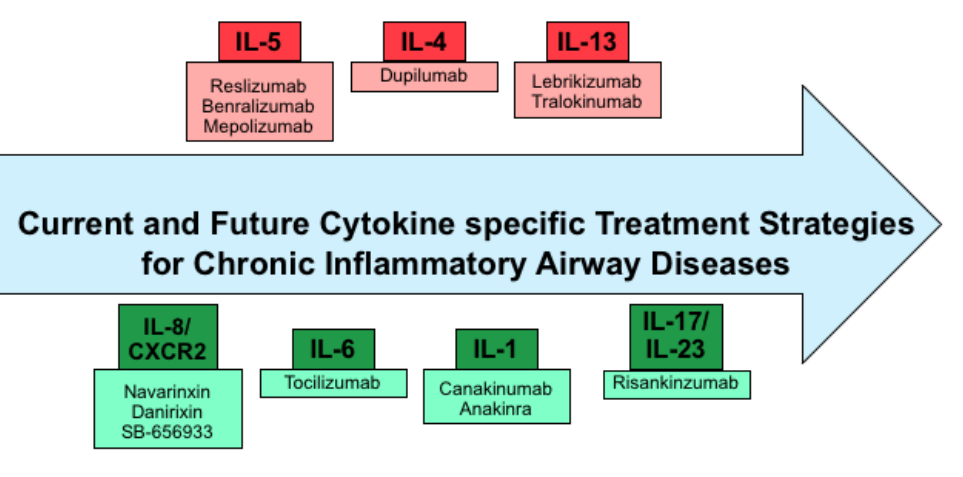
Figure 2. Diagram depicting current and future cytokine specific therapy options, with pink boxes representing established therapies and light green boxes representing therapies that are currently under investigation — cytokines are in either red or green.